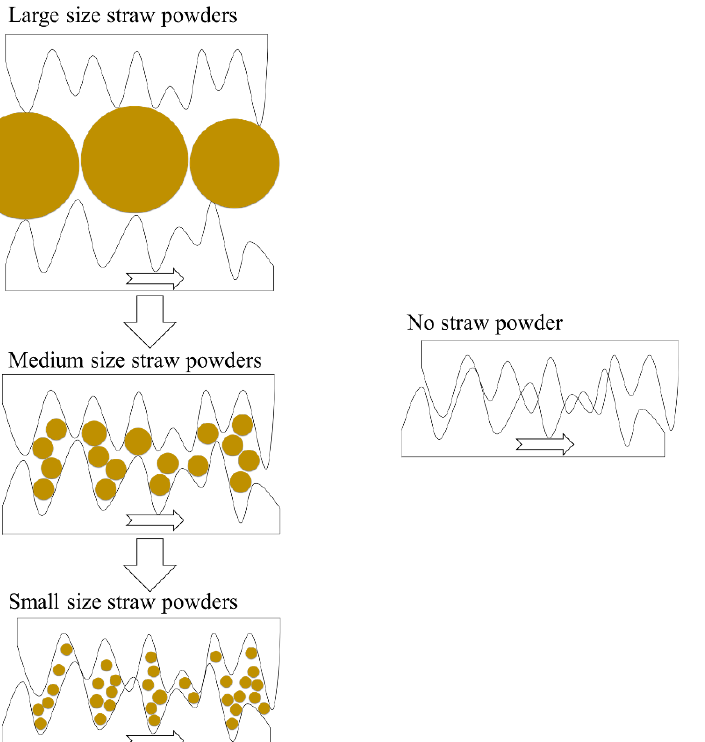
Figure 6. Behavior and evolution process of straw powders with different particle sizes at the contact interface.